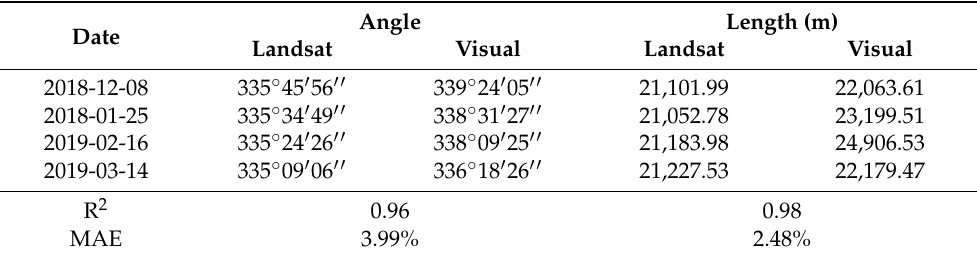
Table 4. The comparison of lake ice fracture using visual interpretation and auto extraction using fractal theory during the cold season between 2018 and